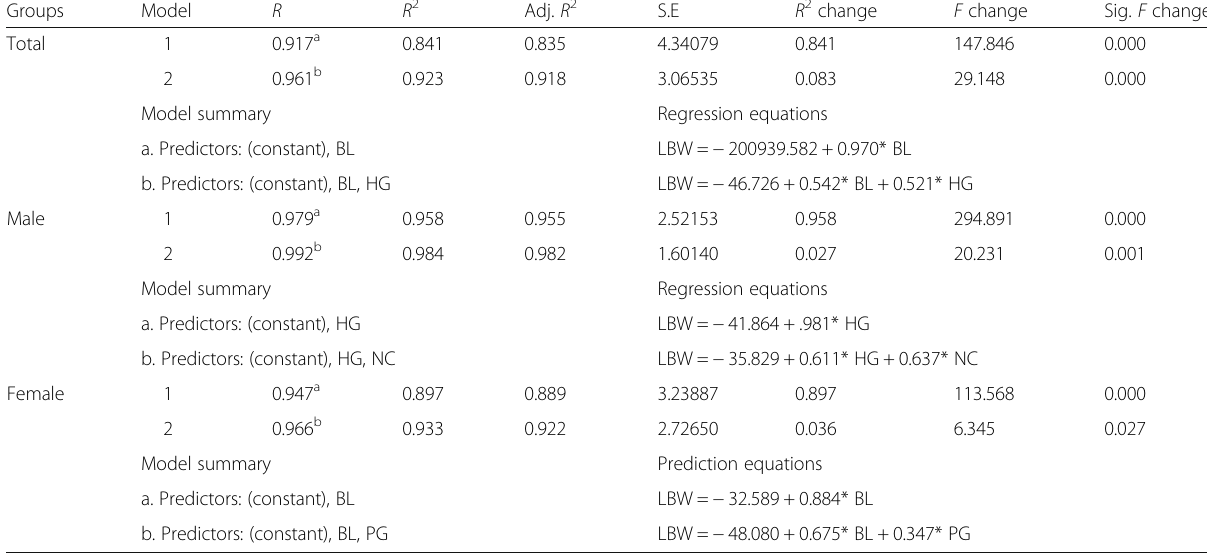
Table 3 Regression equations developed to estimate weight from linear body measurements of Shami goats